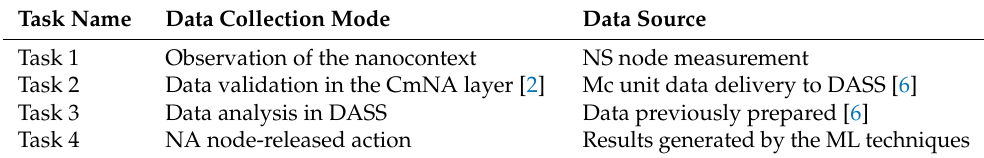
Table 1. Definition of the tasks for the CTM-AC.